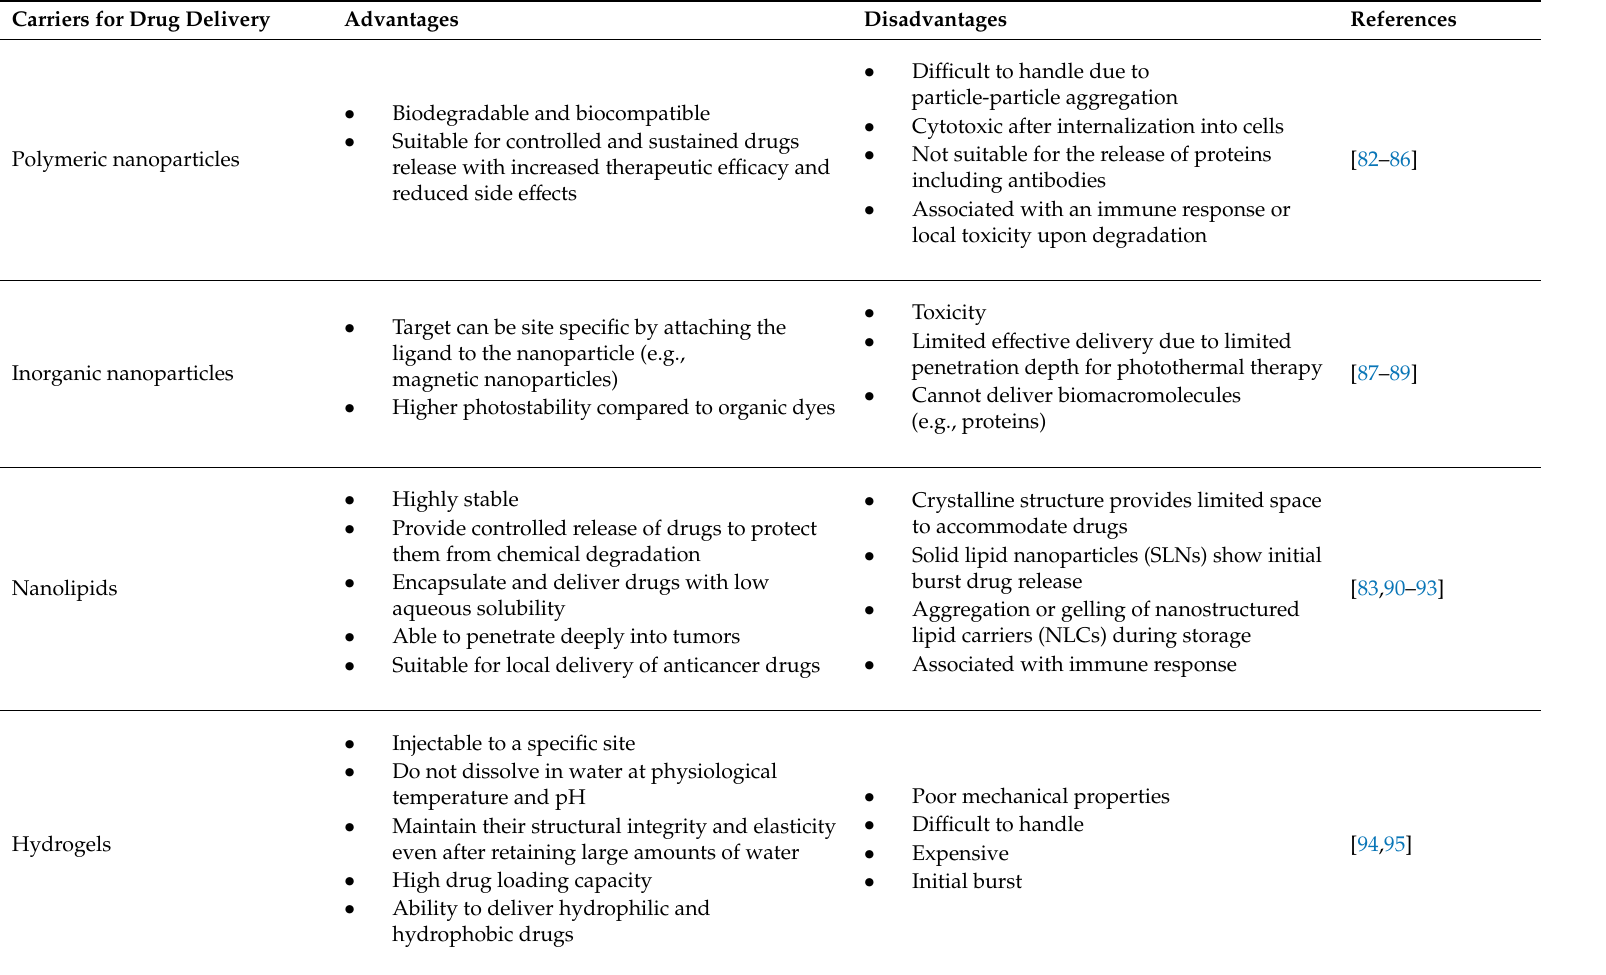
Table 1. Carriers for drug delivery in oral cancer